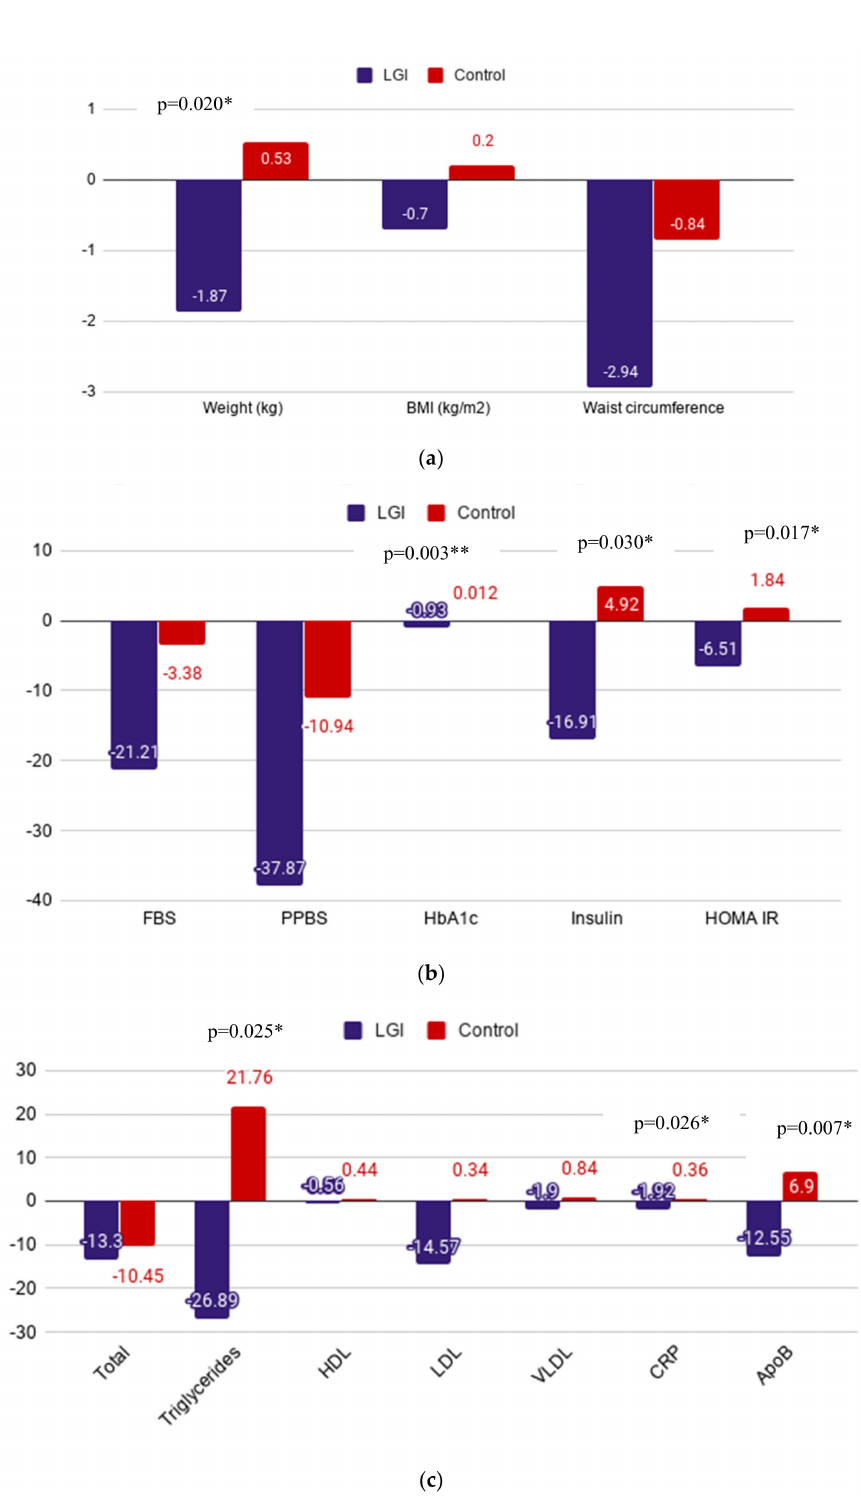
Figure 1. ( a )—The mean di ff erence in the anthropometric measurements; ( b )—biochemical variables—blood glucose levels and insulin resistance; and ( c )—lipid profile and cardiovascular biomarkers after a 24-week diet intervention between the groups. BMI, body mass index; FBS, fasting blood sugar; PPBS, postprandial blood sugar; HbA1c, glycated hemoglobin; HOMA-IR, homeostatic model assessment of insulin resistance; HDL, high density lipoprotein; LDL, low density lipoprotein; VLDL, very low density lipoprotein; hsCRP, high sensitivity C-reactive protein; ApoB, apolipoprotein-B; LGI, low glycemic Index. * Denotes significant di ff